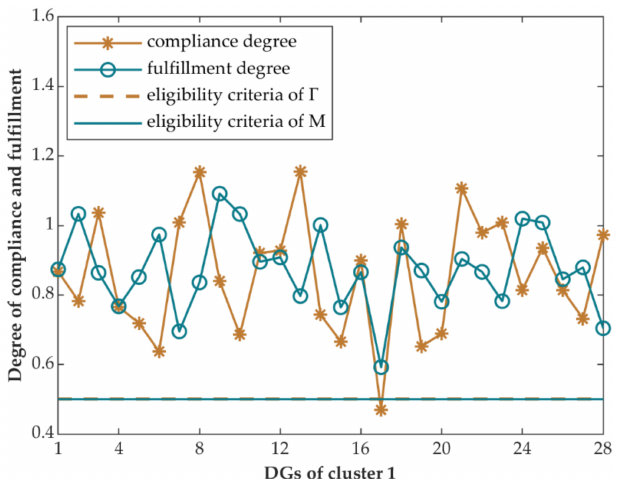
Figure 8. Degree of compliance and fulfillment in cluster